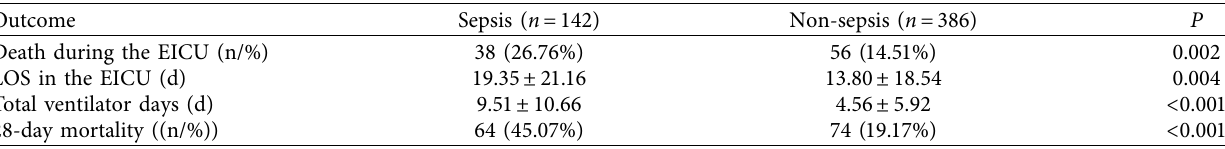
EICU, emergency intensive care unit; LOS, length of stay. Table 5: Patient characteristics between survivor group and non-survivor group.